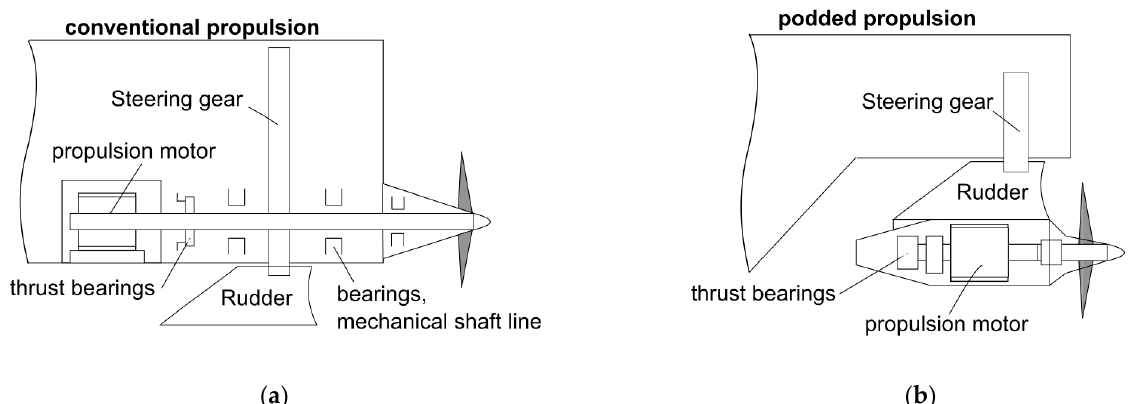
Figure 16. Propulsion system: ( a ) conventional propulsion, ( b ) POD propulsion.